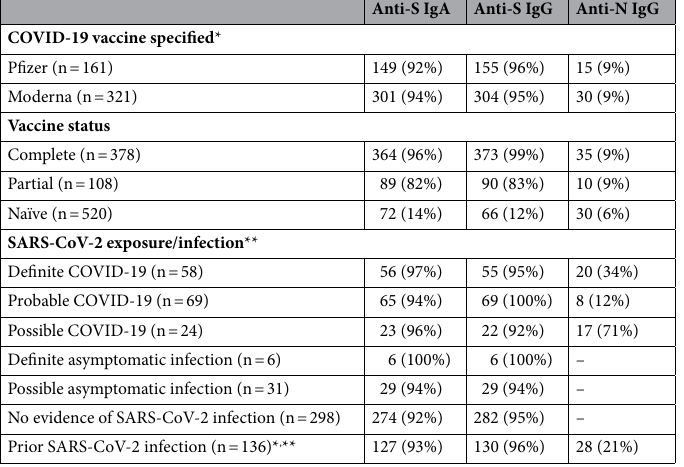
Table 1. Serologic positivity at follow-up by vaccine received and category of SARS-CoV-2 exposure and infection. *One participant received the Janssen vaccine and 3 did not specify. Given the small number those were not included. **Prior SARS-CoV-2 infection was defined as either definite COVID-19, probable COVID- 19 or definite asymptomatic